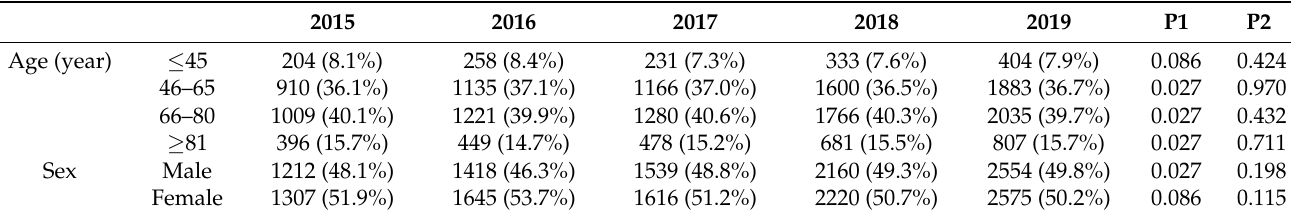
Table 1. Demographic characteristics of the study sample.